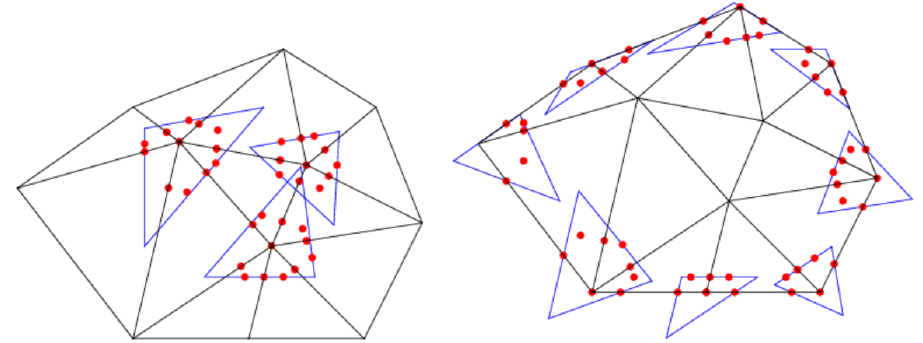
Figure 9. A triangulation with the PS6 triangles obtained by the proposed algorithm.